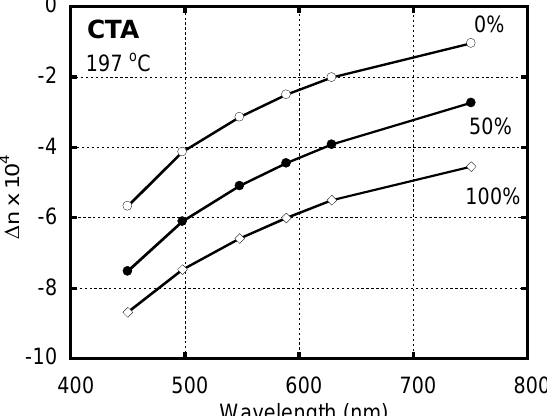
Figure 2. Wavelength dependence of orientation birefringence Δ n for CTA stretched at a draw ratio of 1.5 and exposed to 0% humidity (unfilled circles), 50% humidity (filled circles) and 100% humidity (unfilled diamonds). Drawing temperature is 197 °C.